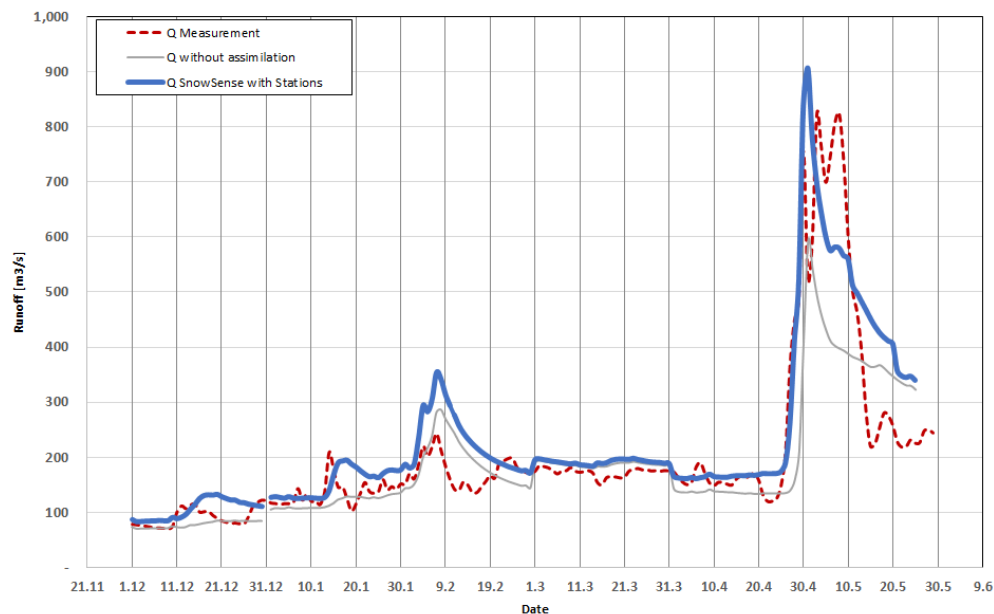
Figure 9. Daily run-off results from PROMET without (grey), with assimilation (blue) of stations and EO against the values (dashed red) measured at Noel Pauls Brook (catchment: 7400 km 2 ) for the winter season 2017/18.